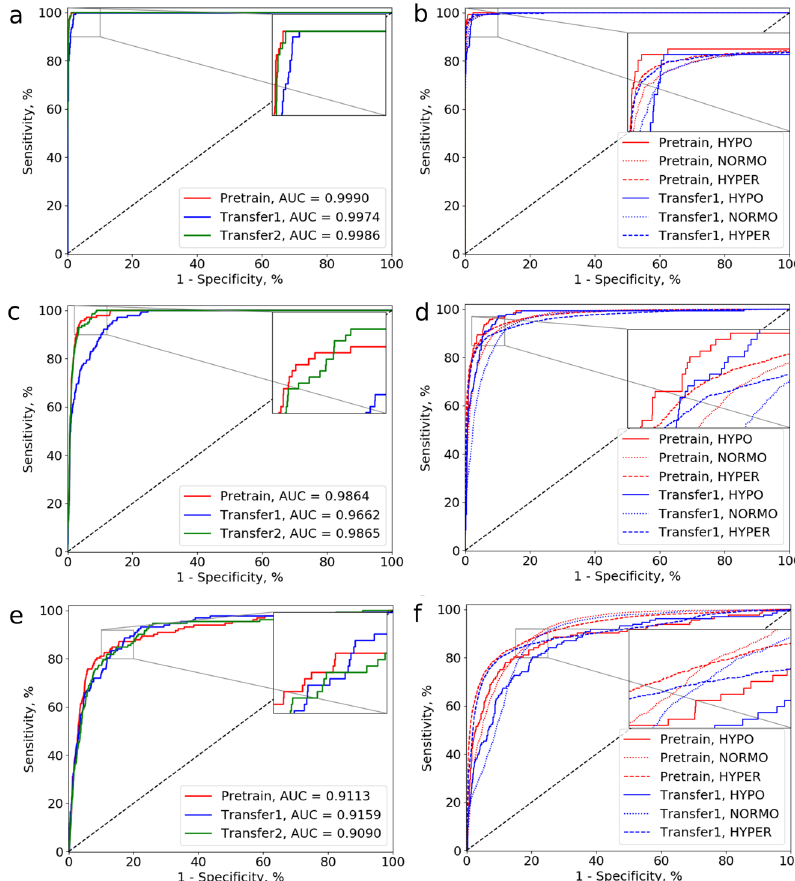
Fig. 4 ROC curves for two classi fi cation tasks given prediction horizons at 5, 30, and 60 min using the best CNN model. a , b Examples of the ROC curves for the prediction horizon at 5 min, in a binary classi fi cation and b three-class classi fi cation. c , d Examples of the ROC curves for the prediction horizon at 30 min, in c binary classi fi cation and d three-class classi fi cation. e , f Examples of the ROC curves for the prediction horizon at 60 min, in e binary classi fi cation and f three-class classi fi cation. AUC, area under the ROC curve. Binary classi fi cation denotes predicting hypoglycemia vs. no hypoglycemia. In three-class classi fi cation, we iterated over the labels (HYPO for “ hypoglycemia ” , NORMO for “ normoglycemia ” and HYPER for “ hyperglycemia ” ) to compute the ROC curves. The results by Transfer2 is comparable to those by Pretrain while those by Transfer3 are worse than Transfer1 and Transfer2, hence we only show the results of Pretrain and Transfer1 for